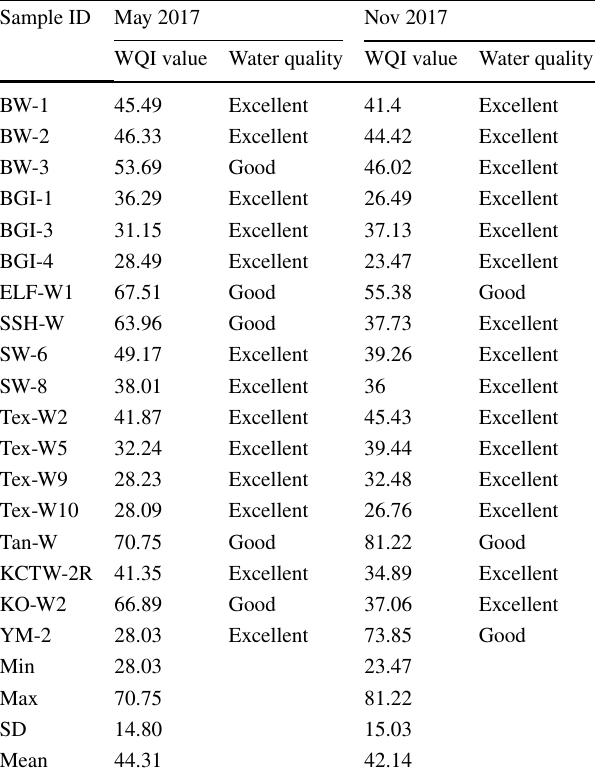
Table 5 Water quality index (WQI) of groundwater samples of the study area